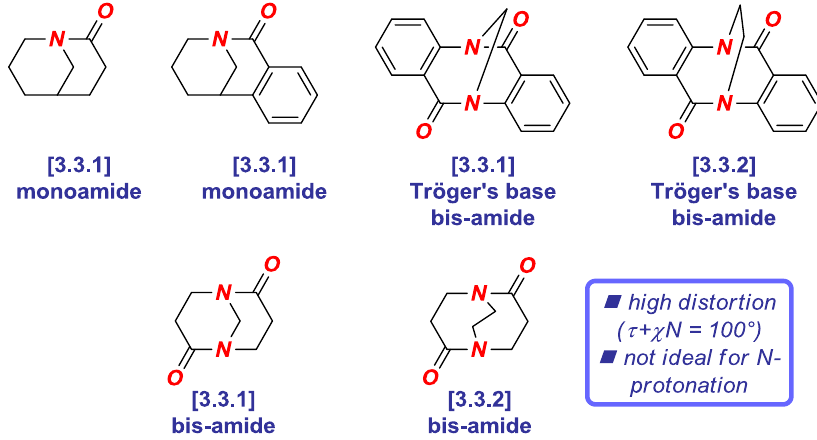
Figure 5. Additive Winkler-Dunitz Distortion Parameter in Tröger’s Base Twisted Amides.